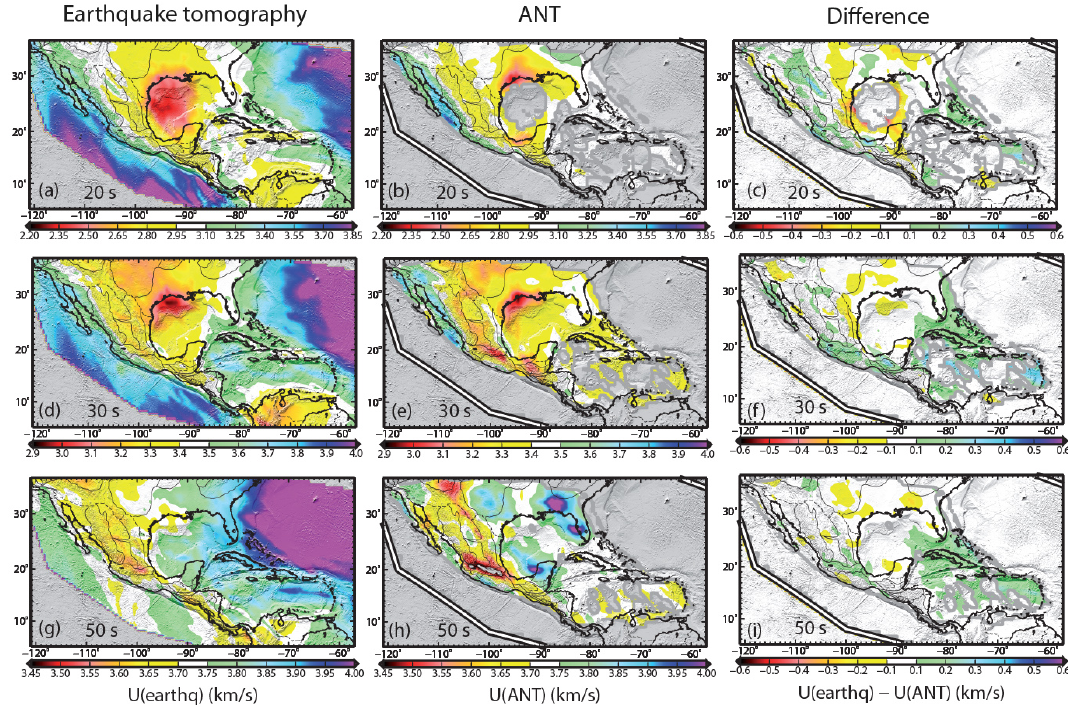
Figure 6. Rayleigh-wave group velocity maps from: earthquake tomography with resolution ≤ 500km (a, d, g) ; ANT with resolution ≤ 250km (b, e, h) ; and their difference in the common area (c, f, i) at 20, 30, and 50s period. The white line outlined by black marks the ANT inversion area.